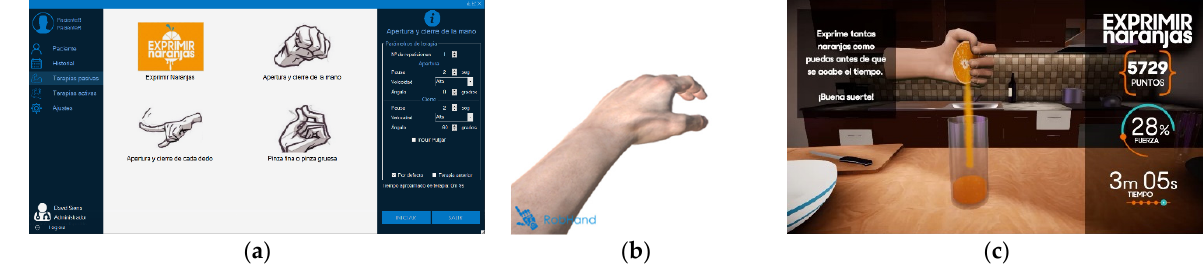
Figure 4. Snapshot of the software environment of RobHand: ( a ) Tab for configuration and selecting passive therapies; ( b ) Virtual reality environment for therapies T1–T3; ( c ) Virtual reality environment for therapy T4.